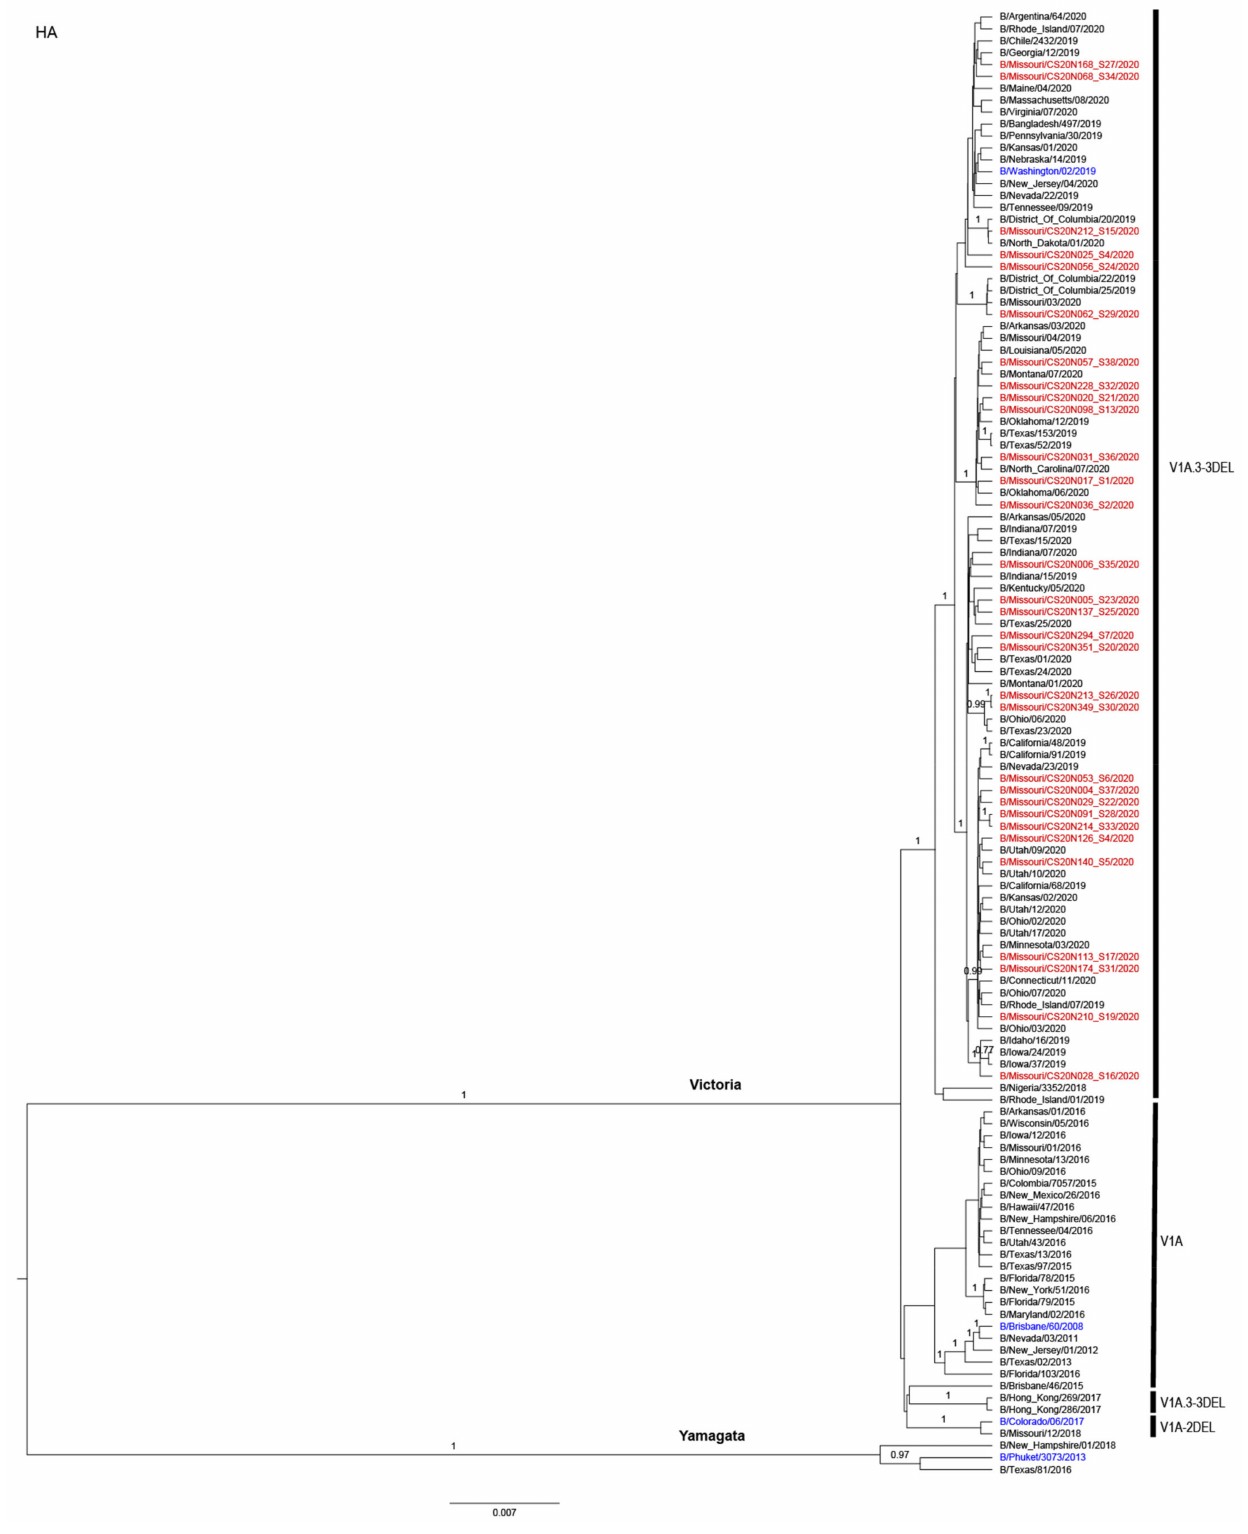
Figure 3. Phylogenetic tree of the HA segment of IBV. Missouri samples from the 2019–2020 season that were collected for this study are labeled in red. Recommended vaccine strains are labeled in blue. The phylogenetic analyses were performed by using BEAST2 with a Hasegawa–Kishino–Yano (HKY) substitution empirical model, strict clock model, and coalescent constant population prior. Branches with a posterior probability ≥ 0.70 were labeled. The nomenclature of the genetic clades is adapted from that reported by the World Health Organization